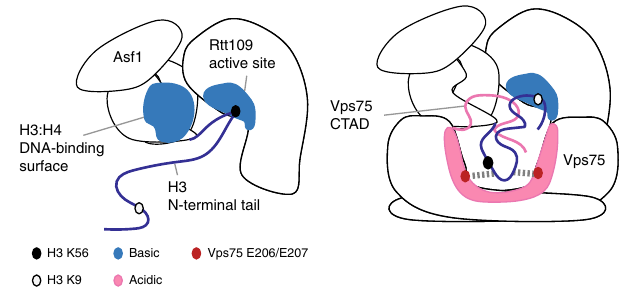
Fig. 6 Fuzzy electrostatic interactions promote acetylation of lysine residues in the H3 tail. Left, the mechanism of chaperoning H3-K56 to the Rtt109 catalytic pocket is based on well-known enzyme-recruitment and substrate-presentation processes. Right, the mechanism by which Vps75 chaperones lysine residues in the H3 tail to the Rtt109 catalytic pocket differs from the canonical substrate-presentation process and includes con fi nement of the H3 tail in the proximity of the Rtt109 catalytic pocket via fuzzy electrostatic interactions occurring between two disordered protein domains, the Vps75 CTAD and the H3